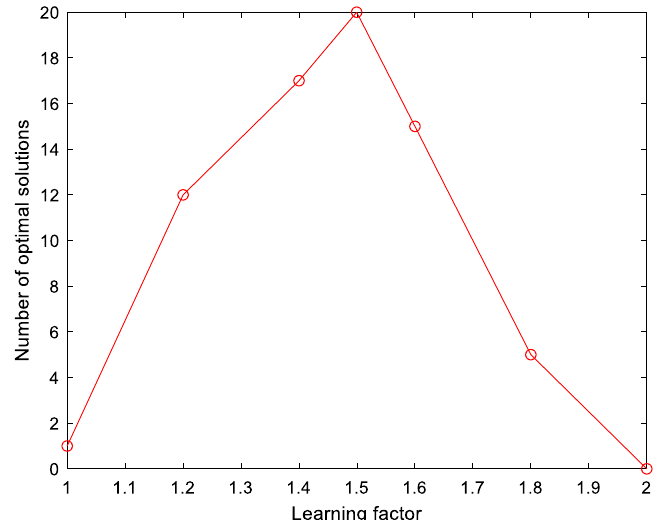
Figure 9. Influence of different learning factors on algorithm performance.